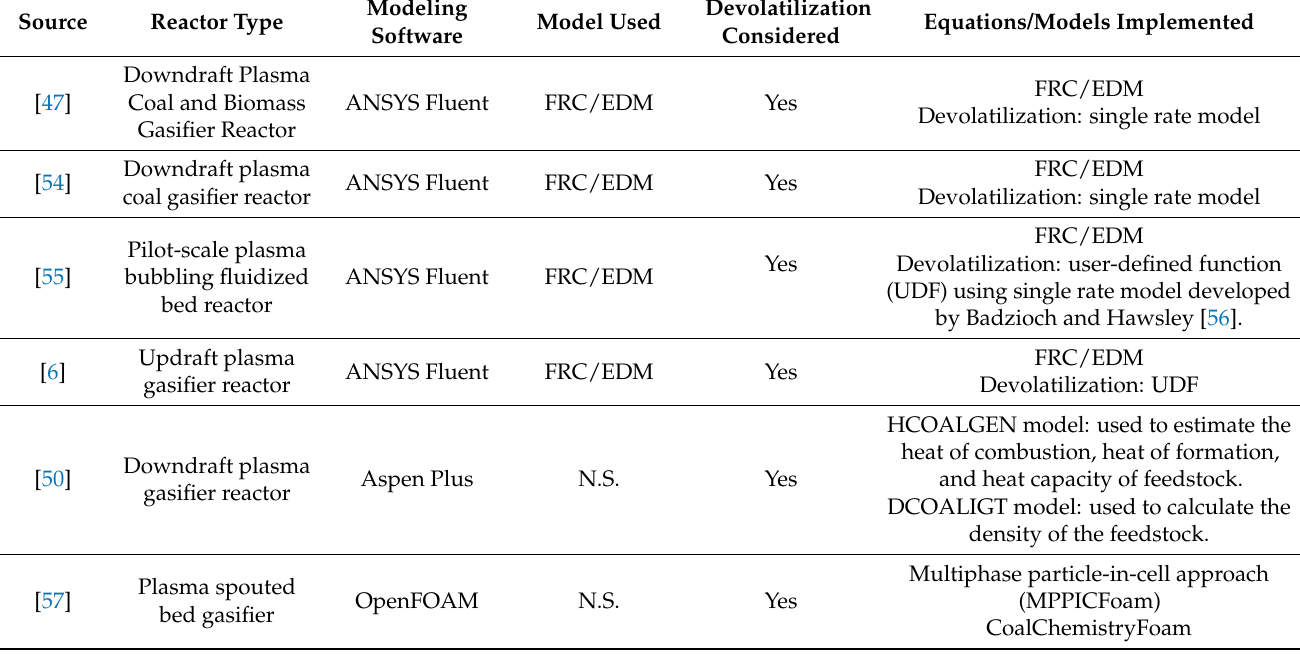
Table 6. Numerical modeling strategies of chemical kinetics within a plasma gasification system